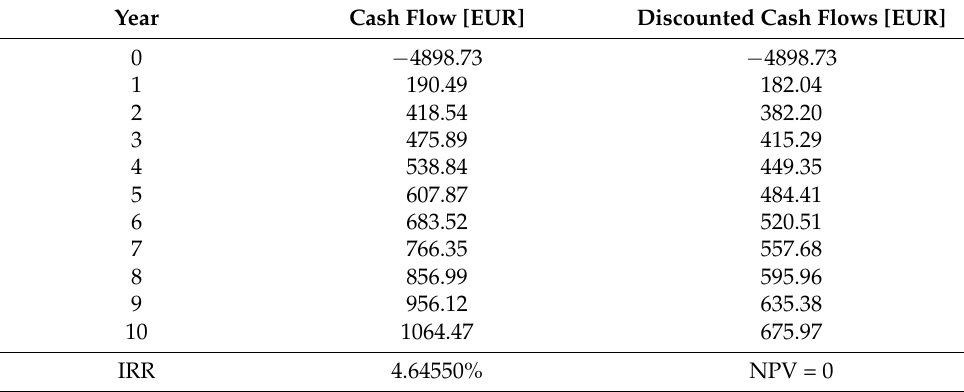
Table 6. Cash flows discounted with the assumed rate of return of